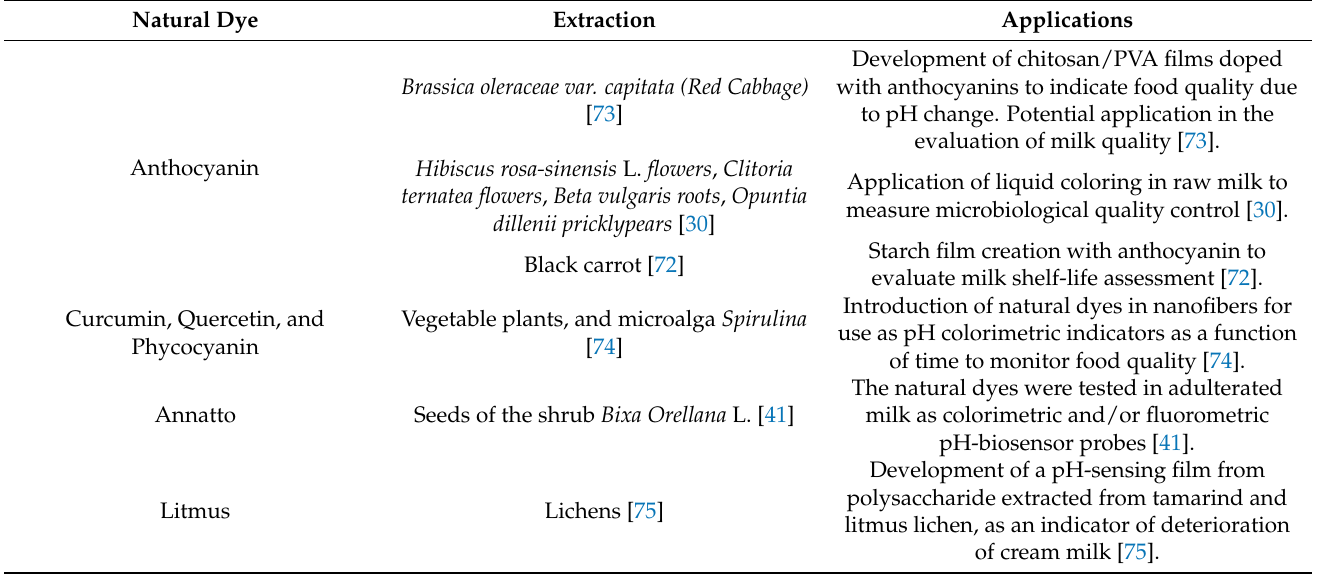
Table 3. Applications of natural dyes as pH indicators in